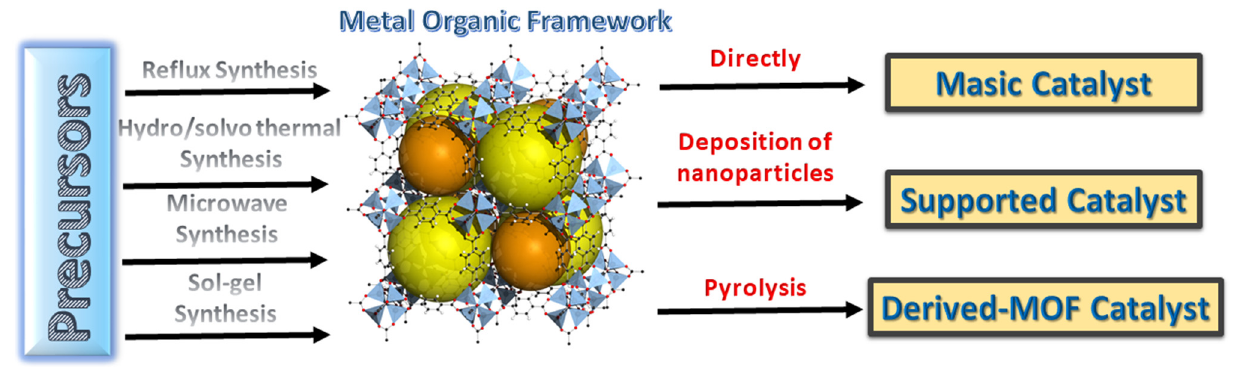
Figure 1. Summary of main routes to obtain catalysts based on MOFs .